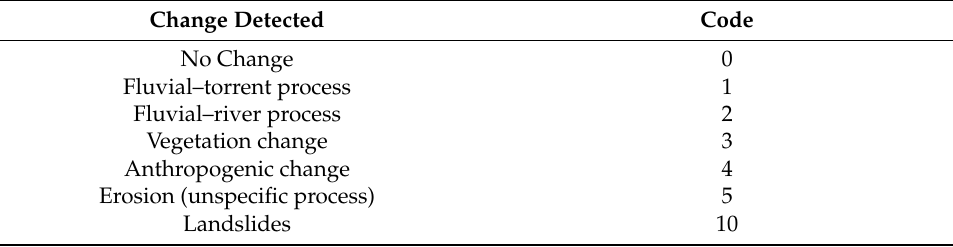
Table 3. new classes re-coding for the classification result.